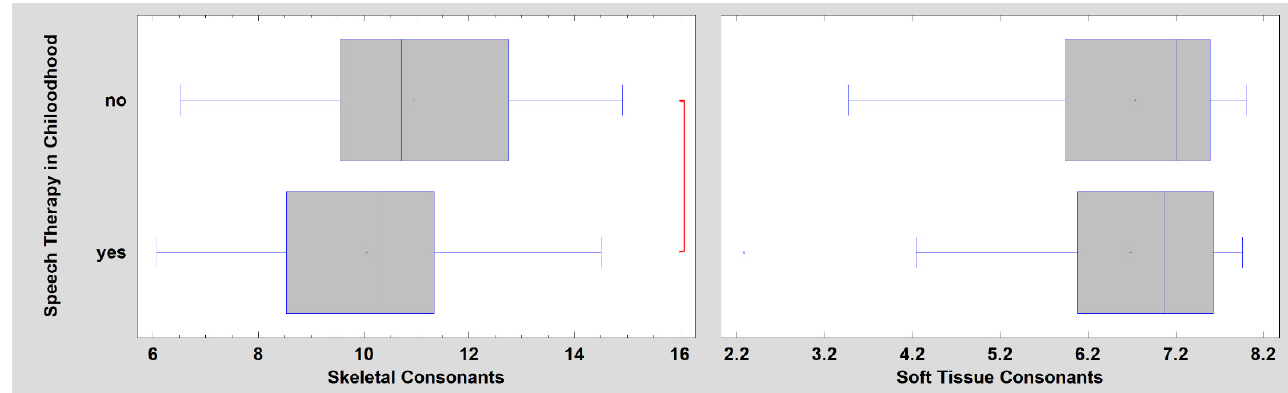
Figure 5. The relationship of speech therapy treatment in childhood to consonant pronunciation test results in adult patients affected by skeletal malformations. The red brackets indicate groups between which there is a significant difference in consonant articulation quality ( p < 0.05).